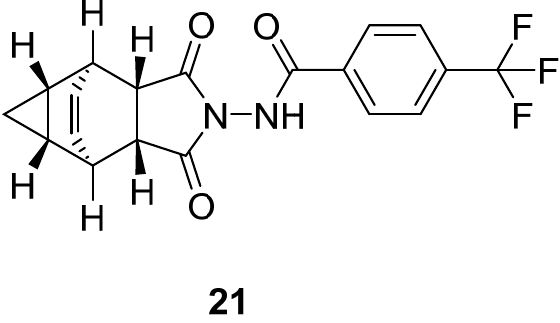
Figure 11. Structure of tecovirimat.